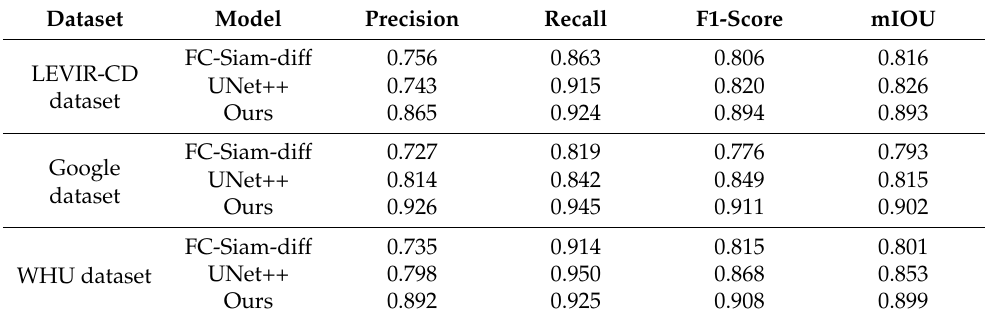
Table 3. Experimental results of the proposed model and other building change detection models.